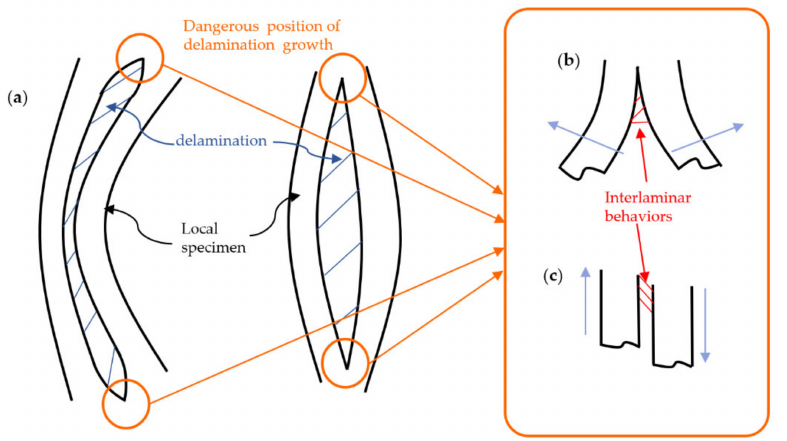
Figure 13. Schematic diagram of the propagation of delamination defect: ( a ) different buckling modes at delamination position, ( b ) crack opening, and ( c )